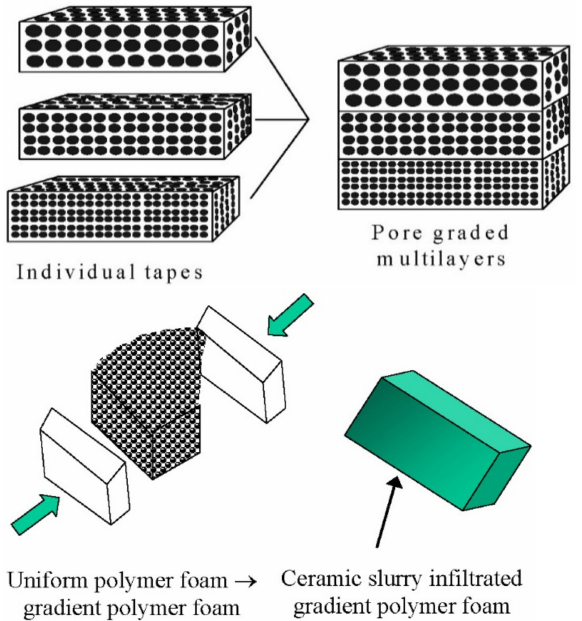
Figure 19. Schematic illustrations of fabrication of pore-graded bioceramics: top—lamination of individual tapes, manufactured by tape casting; bottom—a compression molding process. Reprinted from Ref. [432] with